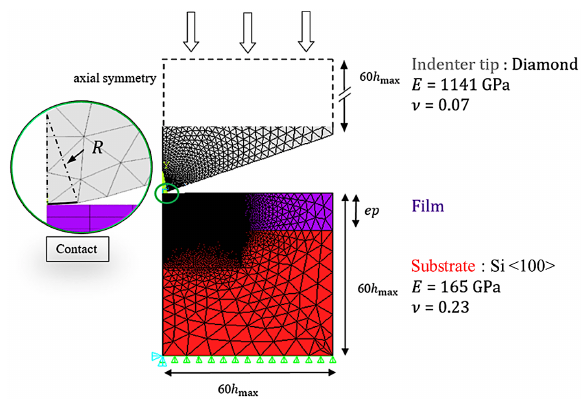
Figure 1. Description of the 2D axisymmetric finite element indentation